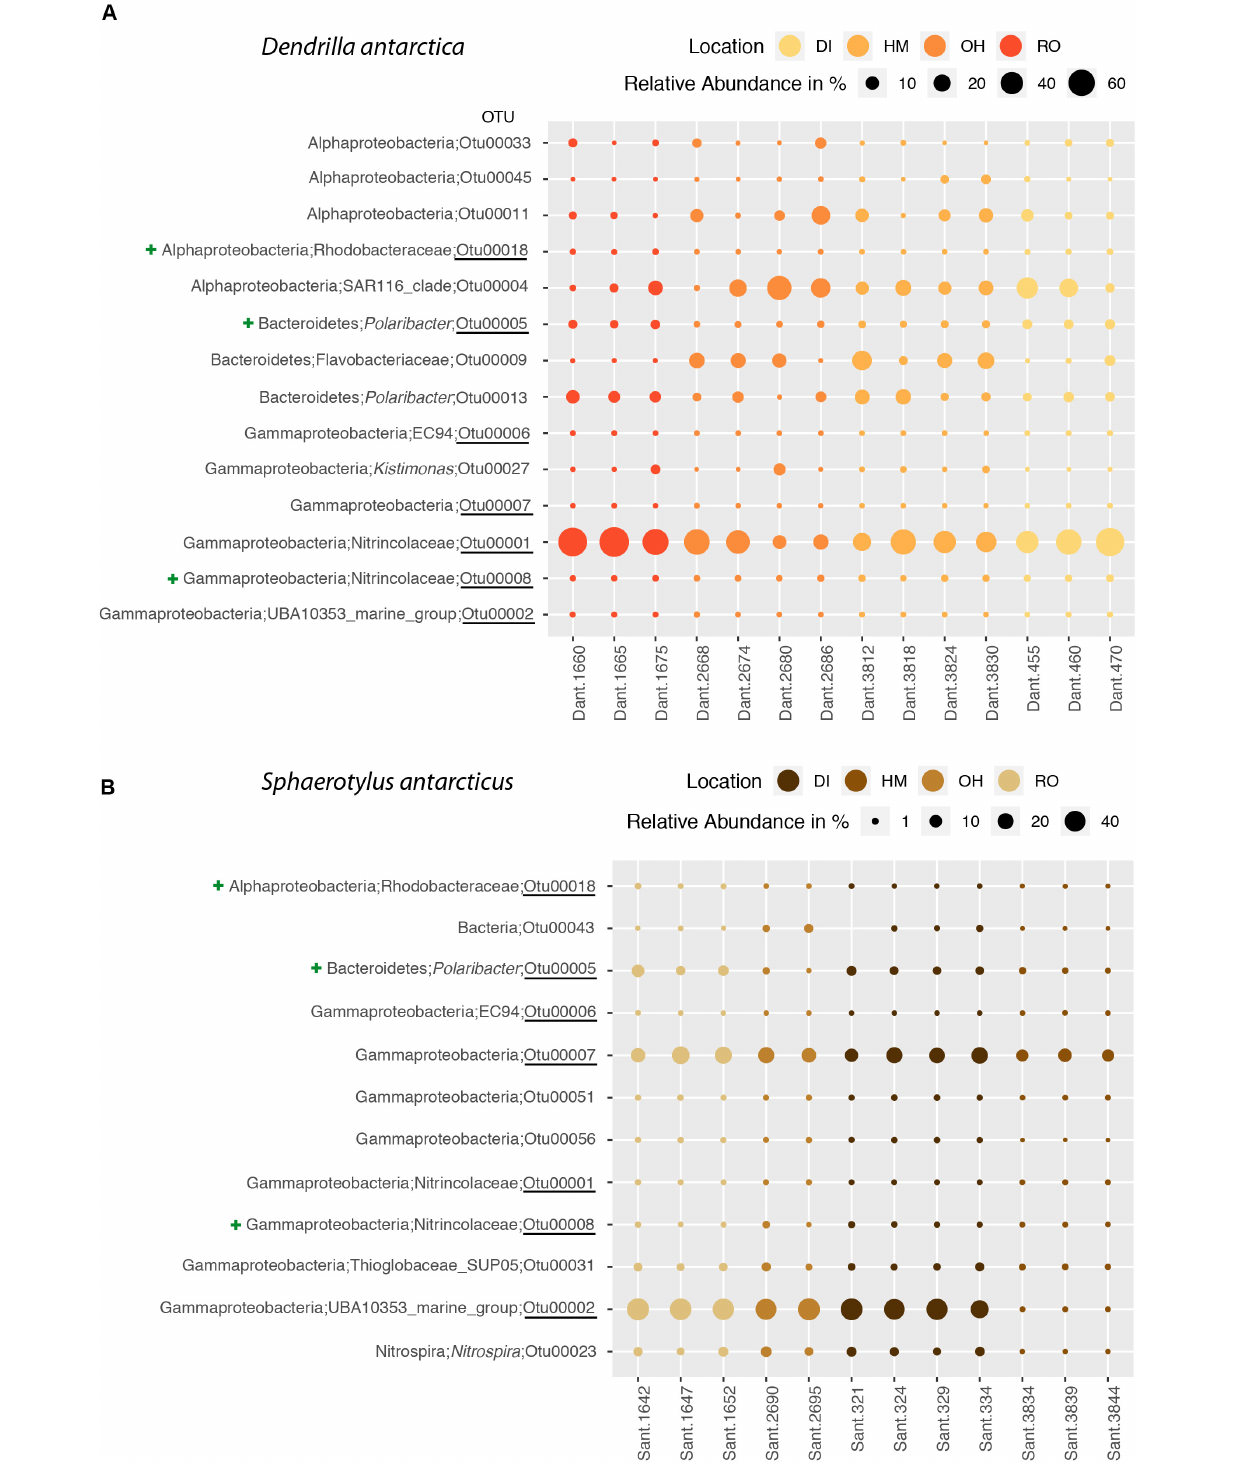
Frontiers in Marine Science |